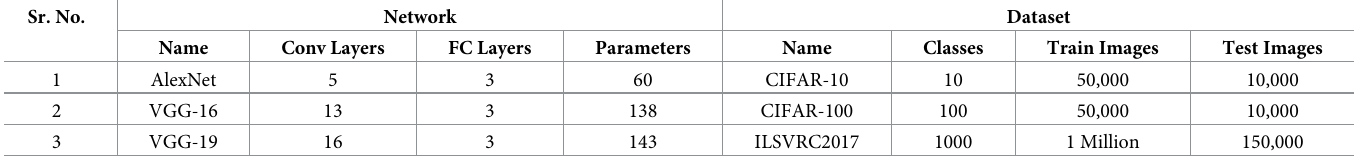
Table 2. Networks and datasets used in the experiments. Sr.